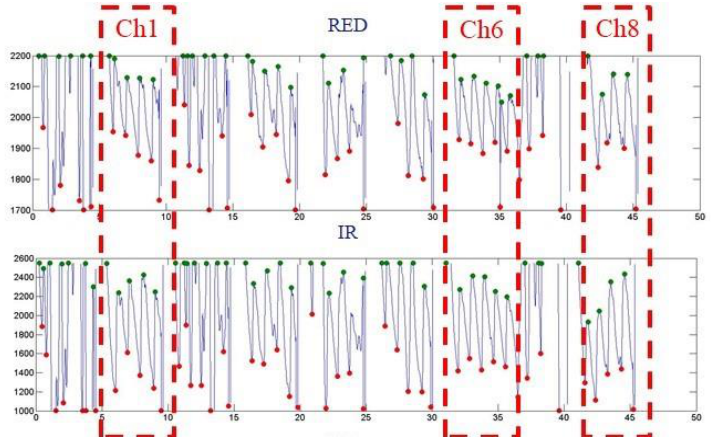
Figure 13. Dynamic state of the blood oxygen concentration value measurement results of a flexible blood oxygen sensing array with a pitch of 3 mm.